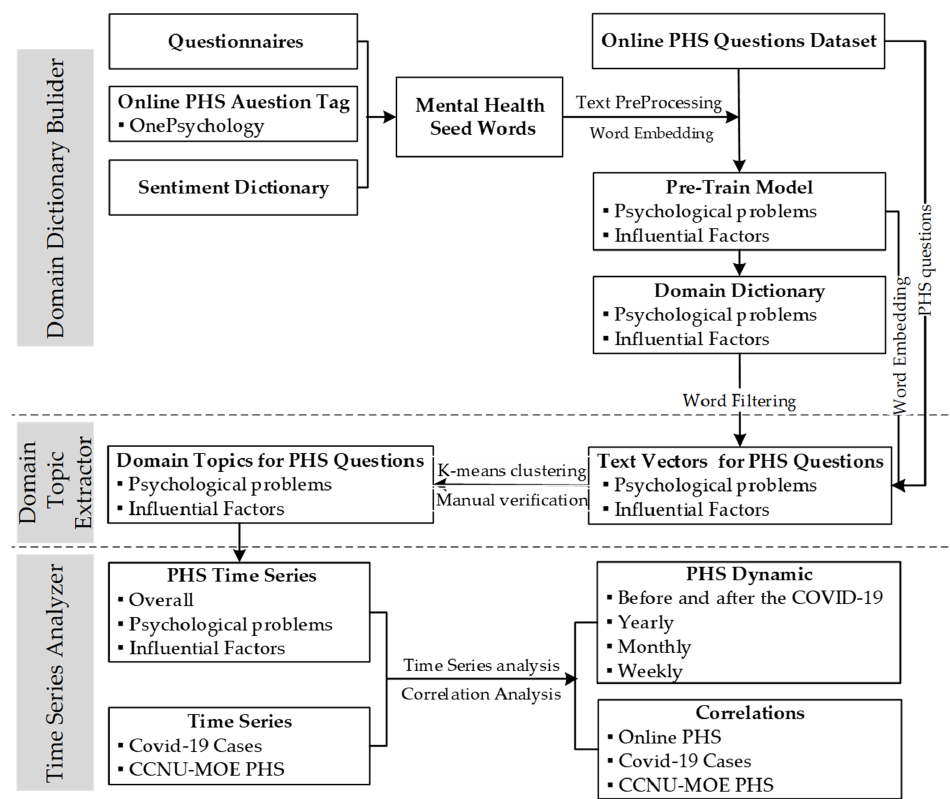
Figure 1. Research methods and